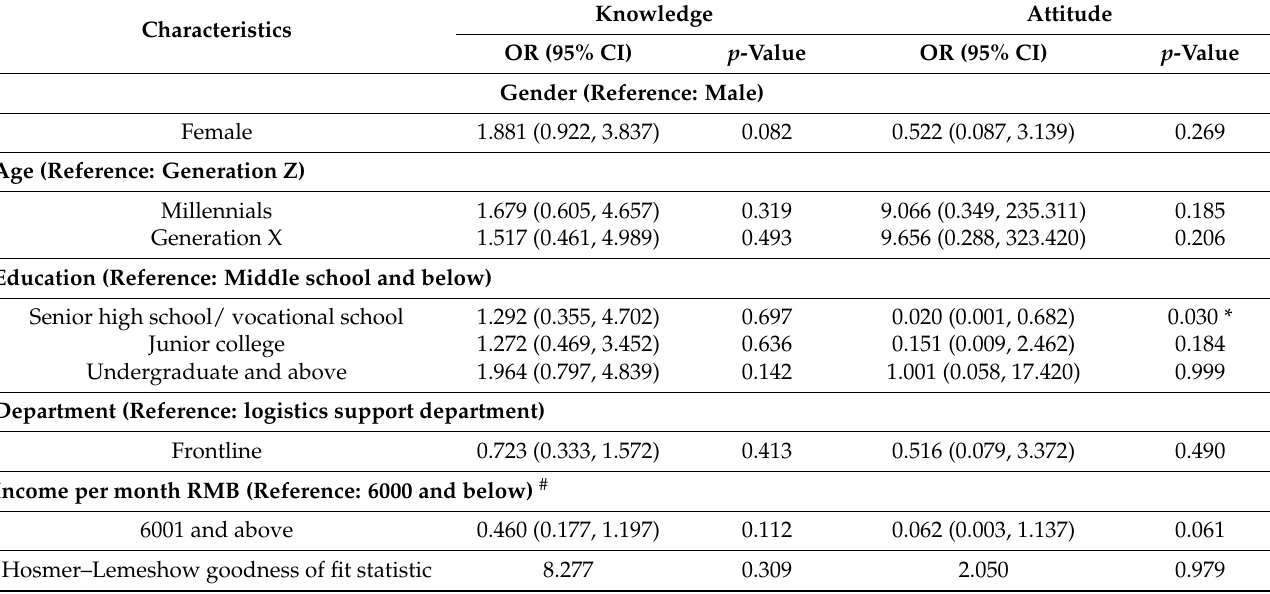
Table 4. Logistic regression analysis for factors associated with good knowledge and optimistic attitude regarding COVID-19 ( N =